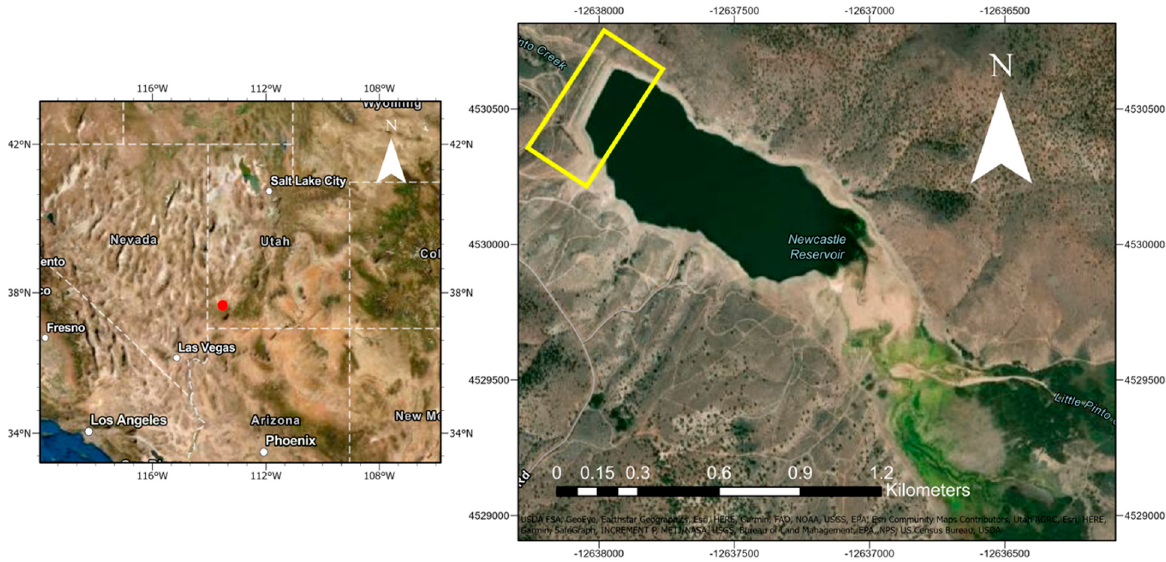
Figure 3. Newcastle Reservoir in southern Utah, USA. The red dot represents the study site within Utah. Newcastle Reservoir Dam (highlighted in yellow) was used to determine the (1) effects of omitting water from the sparse cloud camera alignment; (2) effects of no ground control points; (3) effects of an incorrectly tagged ground control point. Newcastle Reservoir was used to determine how to knit the sonar and shoreline models together, all discussed in Section